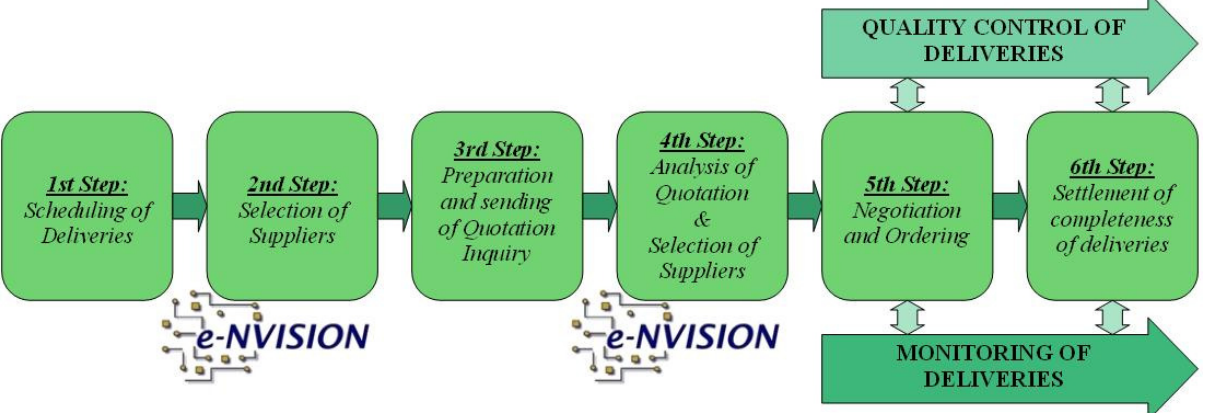
Fig. 2. Schematic representation of procurement